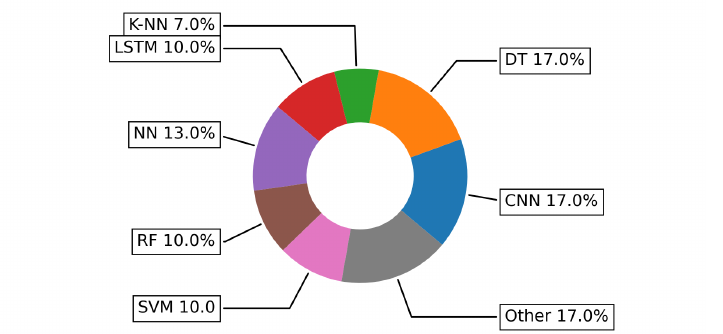
Figure 19. Specific ML and DL algorithms more frequently used in addressing the HAR challenge.